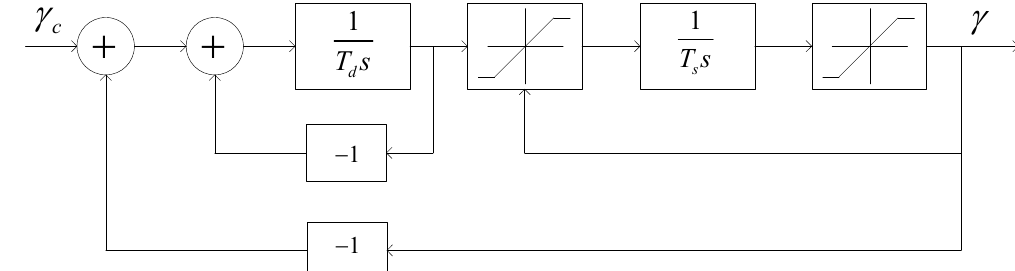
Figure 9. Actuator’s schematic, T s and T d are time constants of the chosen actuator, γ c represents the reference of guide vane